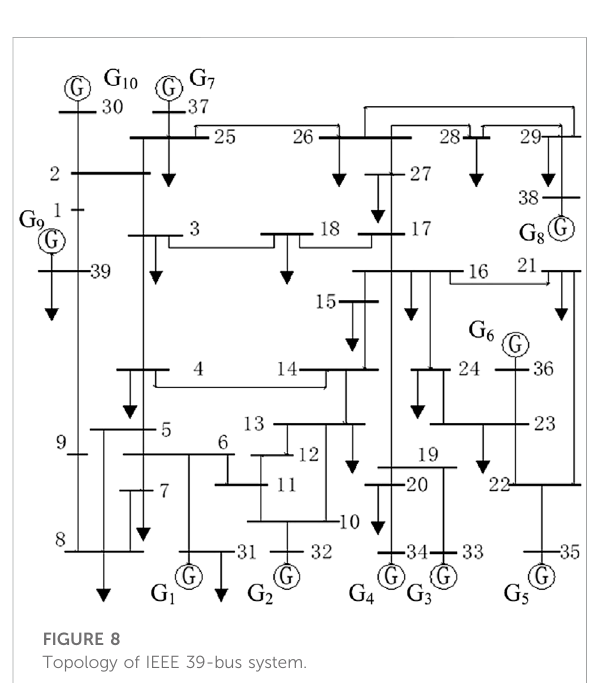
FIGURE 8 Topology of IEEE 39-bus